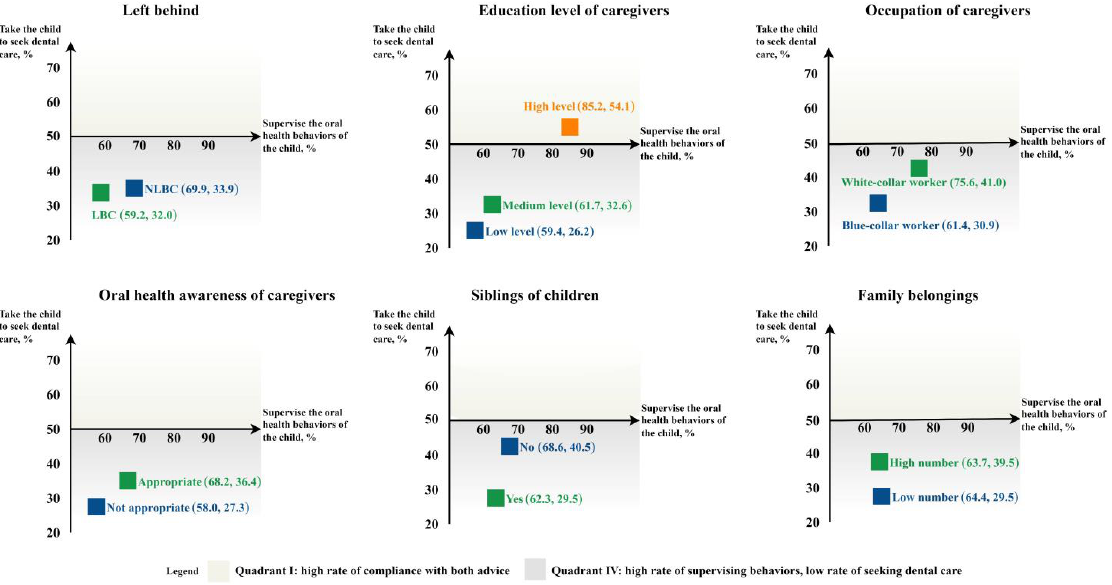
Figure 2. Quadrant diagrams of compliance with supervising oral health behaviors and seeking dental care.